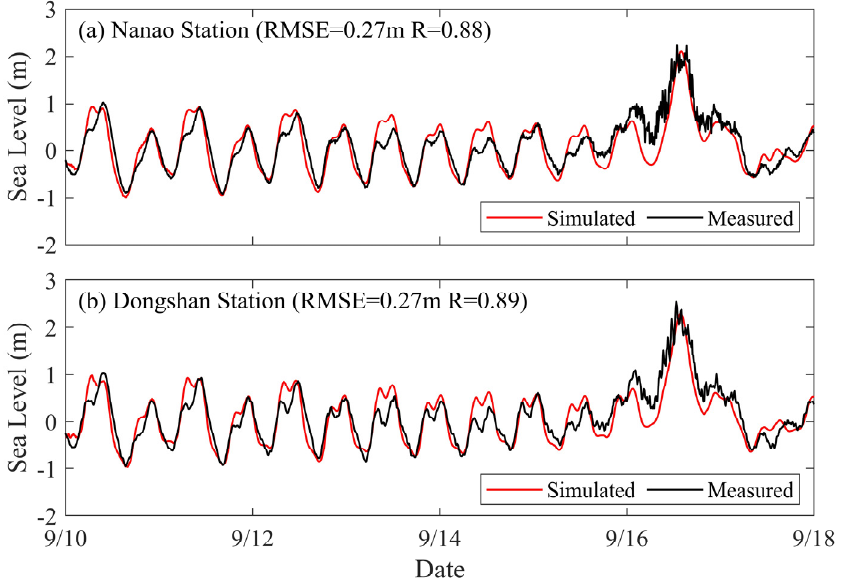
Figure 5. Time series of observed and simulated sea levels at stations ( a ) Nanao in Dapeng Bay and ( b ) Dongshan in Daya Bay. The storm center of Typhoon Mangkhut passed these two stations at 09:00 UTC on 16 September 2018.